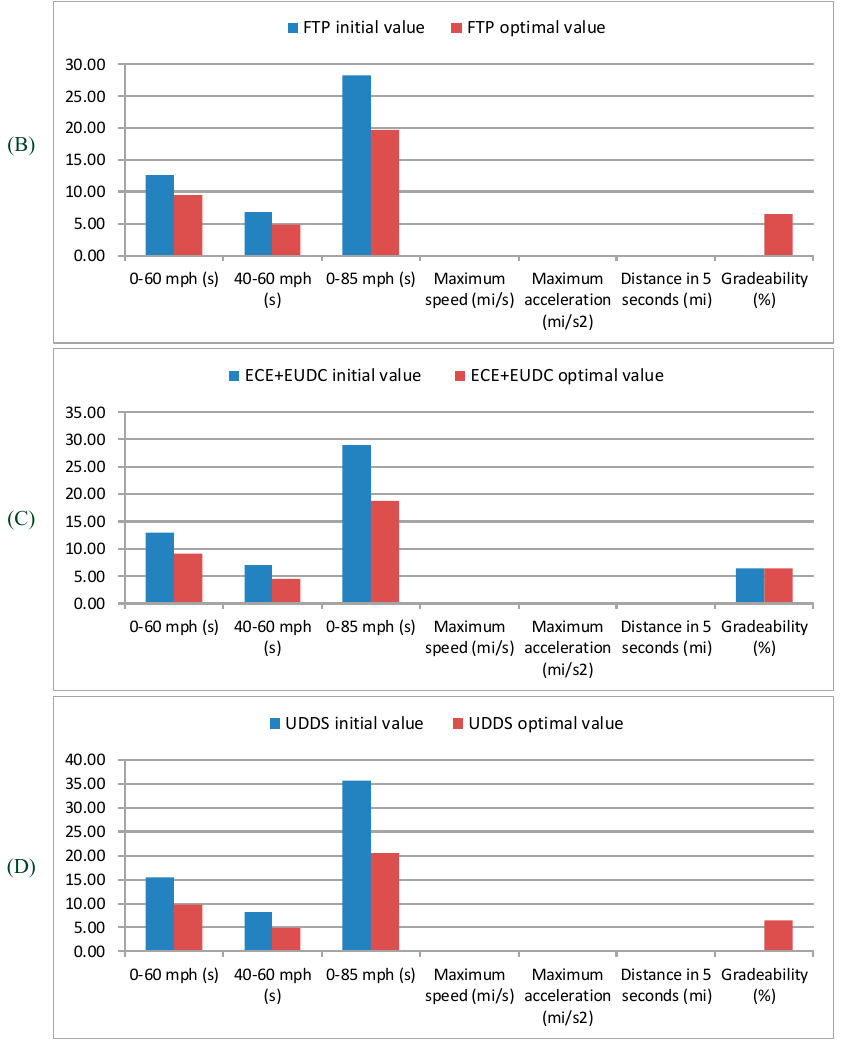
Figure 9. The histogram for dynamic performance using initial and optimal values of the parameters of control strategy. ( A ) dynamic performance based on NEDC cycle; ( B ) dynamic performance based on FTP cycle; ( C ) dynamic performance based on ECE + EUDC cycle; and ( D ) dynamic performance based on UDDS cycle.